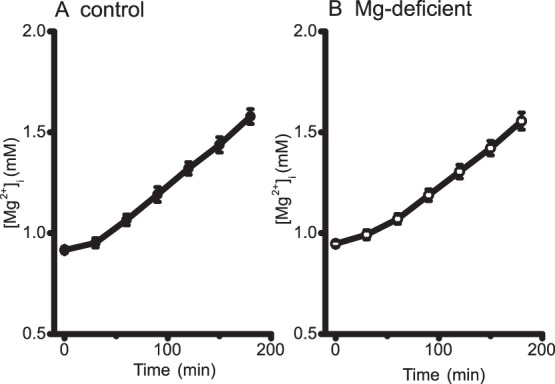
The increase in [Mg2+]i by Mg2+-loading.Measurements of [Mg2+]i from the cells isolated from control (A) or Mg-deficient (B) rats. The incubation solution of the cells was initially Ca2+-free Tyrode’s solution, and was switched to the Mg2+-loading solution at time 0 on the abscissa. Each symbol represents mean±SEM from 22 cells for (A) and 21 cells for (B).